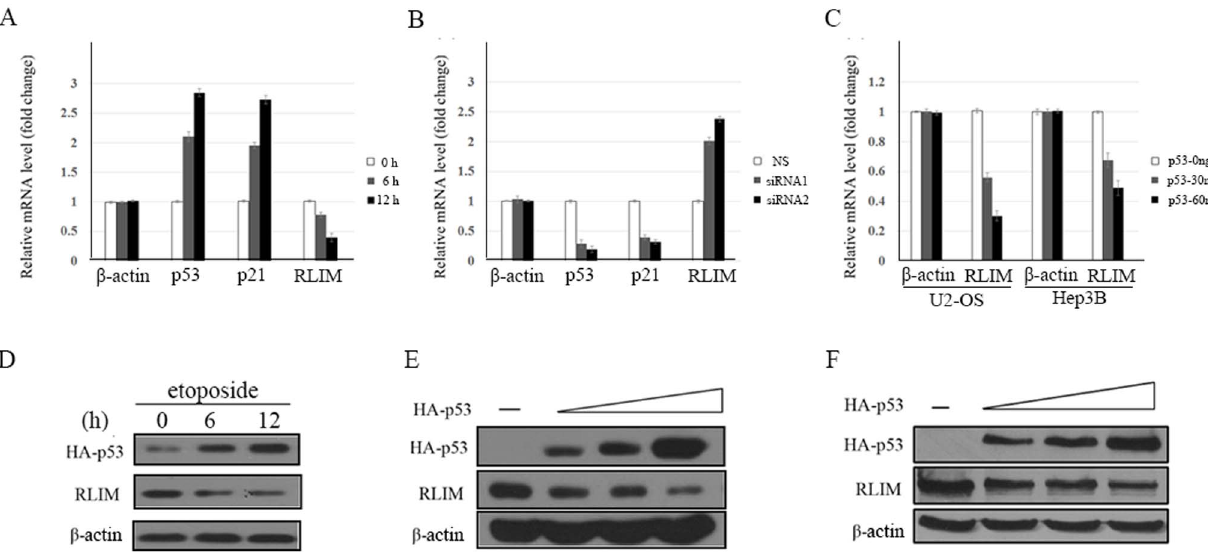
Figure 2. p53 represses RLIM at both mRNA and protein levels. ( A ) U2-OS cells were treated with 20 m M etoposide for the indicated period (0, 6 and 12 h) to induce the expression of endogenous p53. Cells were harvested for total RNA isolation followed by qPCR using primers specific for RLIM, p21, p53 and b -actin mRNA, respectively. ( B ) U2-OS cells were transfected with 20 m M p53 siRNA or 20 m M NS (non-specific) siRNA as control. RNA isolation and qPCR were performed as described above. ( C ) U2-OS or Hep3B cells were transfected with increasing amounts of p53 and harvested 24 h after transfection. Cells were harvested for total RNA isolation followed by qPCR using primers specific for RLIM and b -actin respectively. ( D ) U2-OS cells were treated with 20 m M etoposide for the indicated period (0, 6 and 12 h) to induce the expression of endogenous p53. Cells lysates were immunoblotted with antibodies to p53, RLIM and b -actin. ( E ) U2-OS or ( F ) Hep3B cells were transfected with different amount of plasmids encoding p53. Cells were harvested 40 h after transfection and lysates were immunoblotted with antibodies to p53, RLIM and b -actin. RLIM-Reverse, 5 9 - TAGAACGTCTTGCAGATGGCTC -3 9 ; p53-Forward, 5 9 - CATCCTCACCATCATCACACTG, p53-Re-